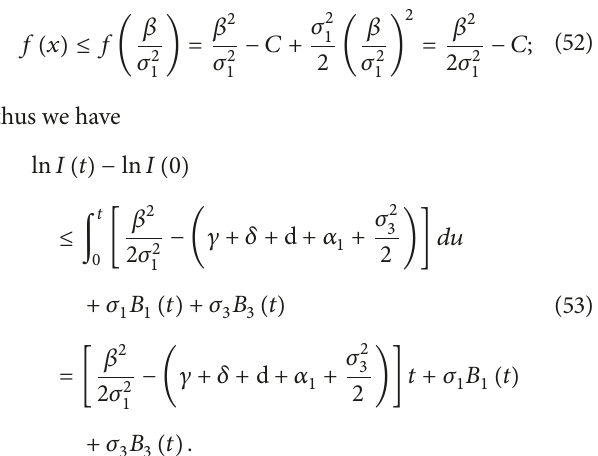
≤ 𝛽 and ̂𝑅 𝑠 < 1 0 1